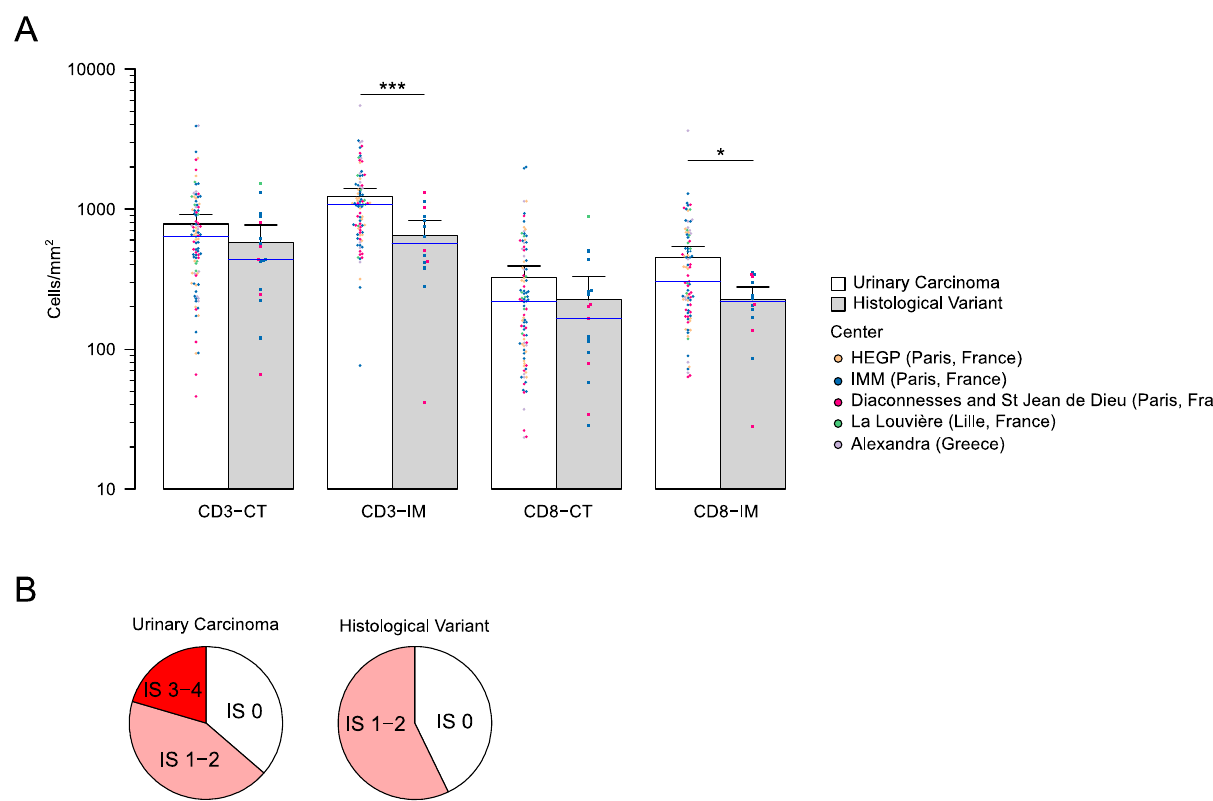
Figure 1. The immune infiltrate and histological variants: ( A ) patient groups comparing the immune densities in classical urothelial carcinoma to other variants and ( B ) distribution of the Immunoscore in urothelial carcinoma and other variants. * p -value < 0.05, *** p -value < 0.005.